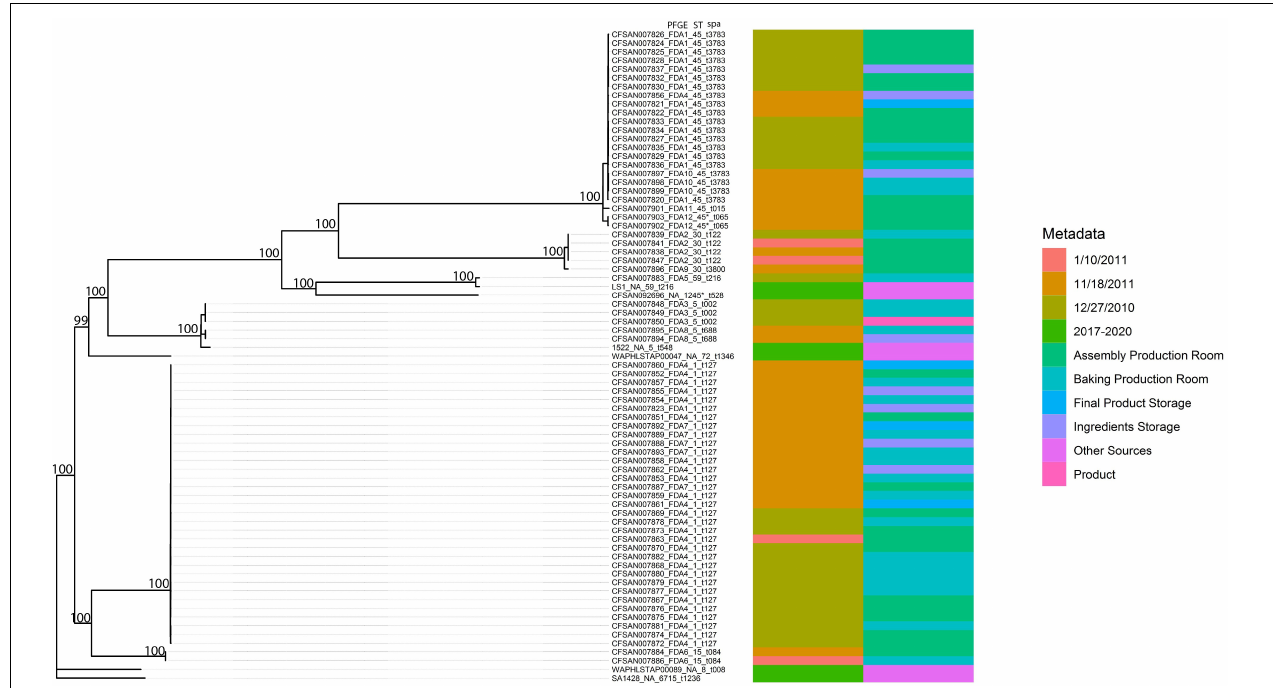
FIGURE 2 | Phylogenetic tree inferred from a SNP matrix generated with kSNP3 and RAxML. Branch lengths are inferred number of substitutions per site and numbers at nodes represent percent bootstrap support.